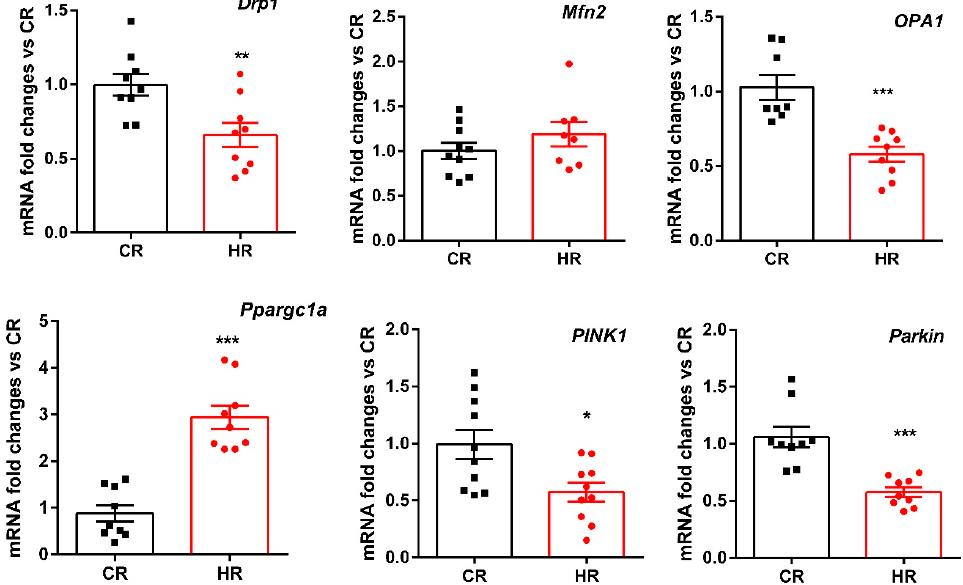
Figure 4. Fold changes of mRNA expression of mitochondrial dynamics, biogenesis and mitophagy genes in liver of experimental animals. CR, control; HR, hyperthyroidism.*— p < 0.05, **— p < 0.02, ***— p < 0.001 as compared with the control data ( n = 10).